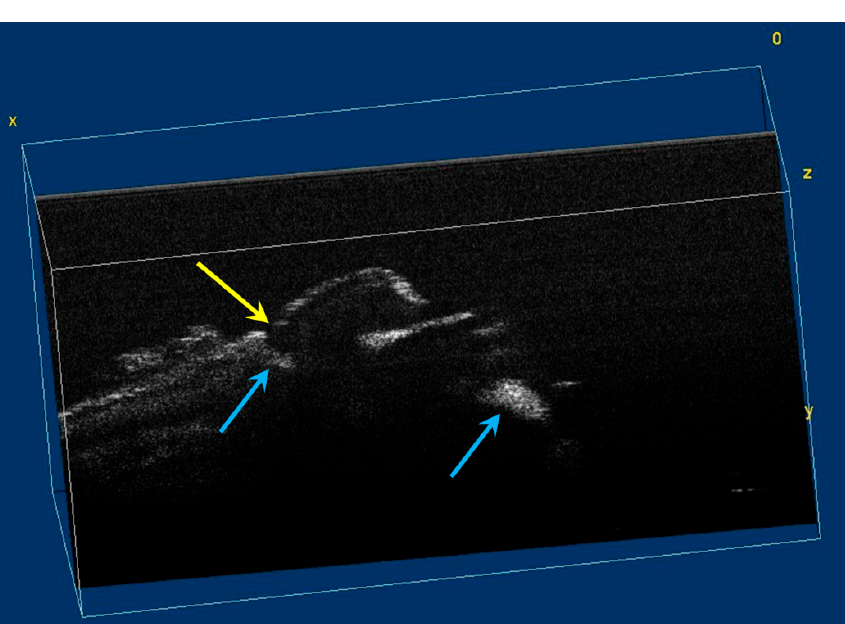
Figure 7. Volumetric reconstruction (in ImageJ) of hypomineralization areas marked by blue arrows. The yellow arrow indicates a small hypoplasia lesion, which was not initially identified in 2D OCT images analysis.